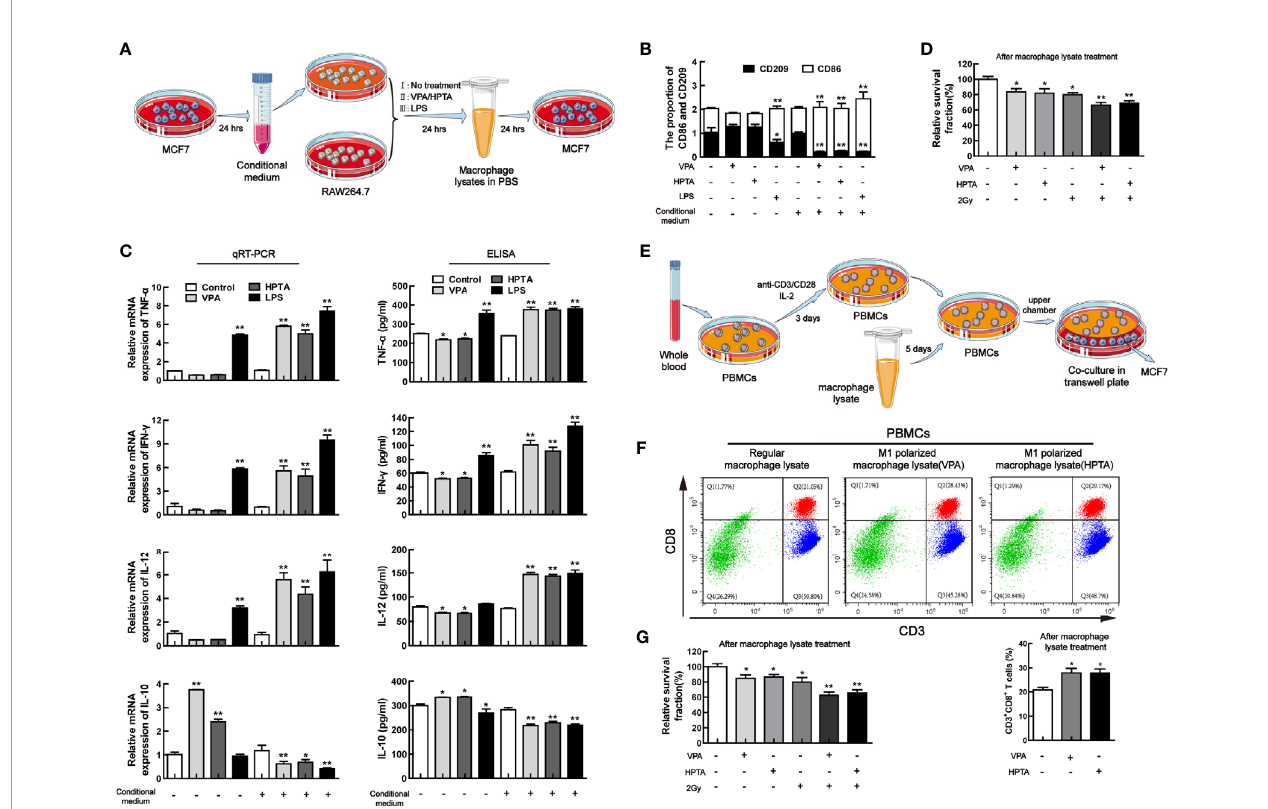
FIGURE 7 | VPA/HPTA can directly promote M1 polarization of macrophages to activate anti-tumor response of CD8+ T cells in vitro (A) Protocol for MCF7 conditional medium and macrophage polarization experiment. (B) qRT-PCR analysis of markers (CD86 and CD209) of reprogrammed RAW264.7 macrophages under different treatment conditions. (C) qRT-PCR and ELISA analysis of cytokines (TNF- a , IFN- g , IL-10 and IL-12) of reprogrammed RAW264.7 macrophages under different treatment conditions. (D) The survival of MCF7 cells treated with macrophage lysate was detected by MTT assay. (E) Protocol for extraction and activation of PBMCs and the co-culture with MCF7 cells. (F) Flow cytometric analysis of the effect of macrophage lysates on CD8 + T lymphocytes. (G) MTT results of survival of MCF7 cells after co-culture. Each data point in the graphs was from three independent experiments (mean ± SD). P-values were calculated by Student ’ s t-test (* P < 0.05, ** P <